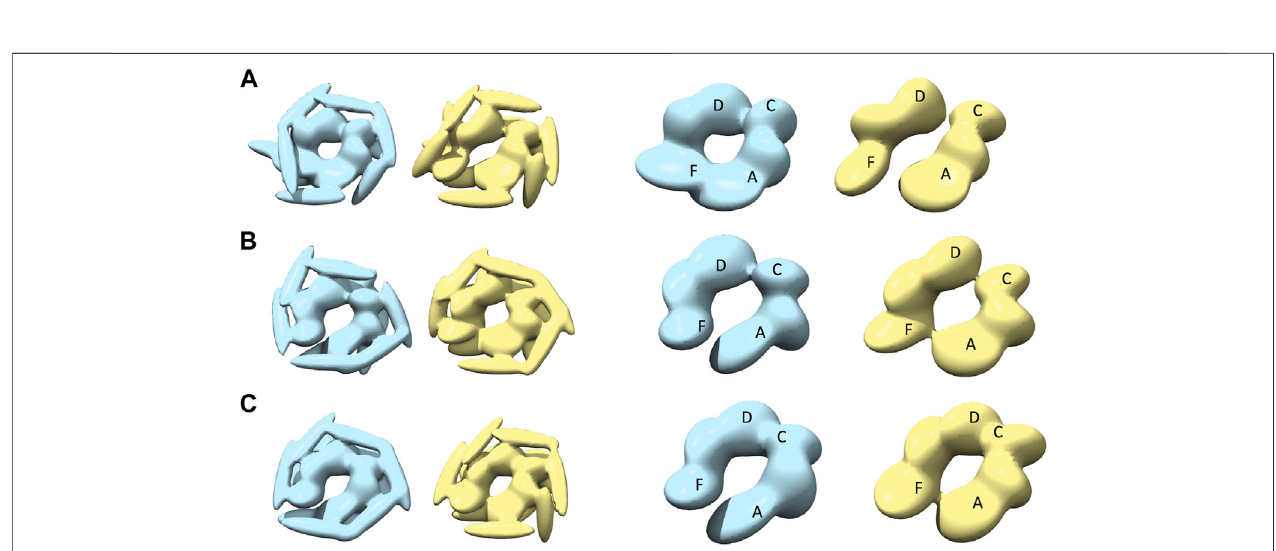
FIGURE7| ThemostconvergedmodelbetweenstructuralmodelingstartingfromR(lightblue)andS(yellow)forhalf-spiralclassAFMimages.Therows (A – C) are for AFM images 10, 11, and 12, respectively. In the third and fourth columns, only the body kernel are shown from R and S candidate solutions given in the fi rst and second columns, respectively. The chains A, F, C, and D are shown on top of the kernels.